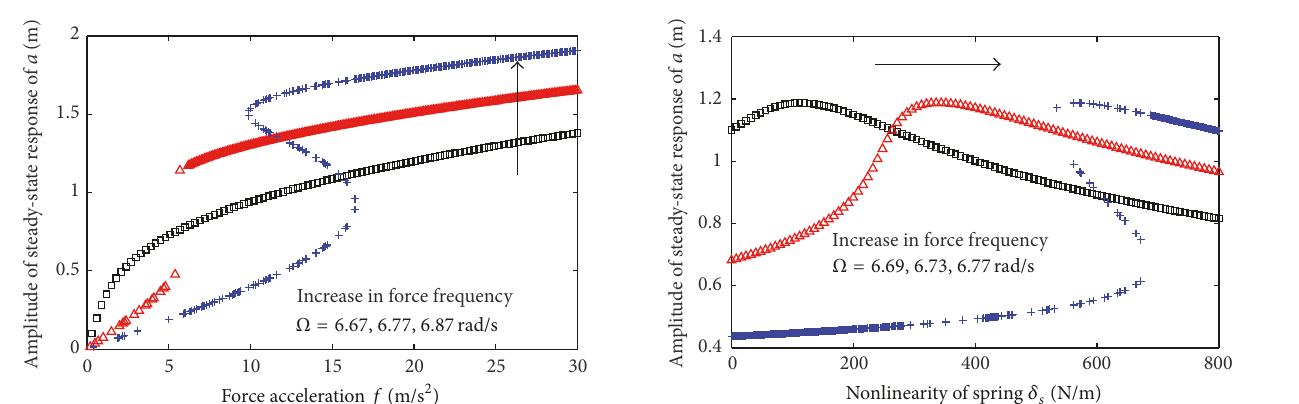
Figure 5: The effect of varying force frequency Ω on force accel- eration response of vibration 𝑎 . Ω = 6.67 rad / s ( black squares), Ω = 6.77 rad / s (red triangles), and Ω = 6.87 rad / s (blue crosses).